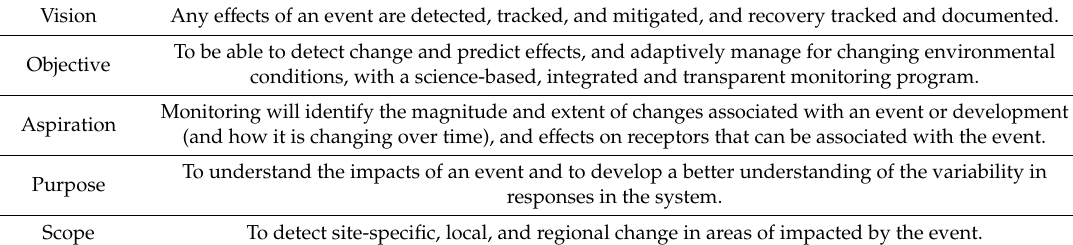
Table 2. Example of initial needs for program design. The example below is for a major event, and is meant as an example of the specificity required.